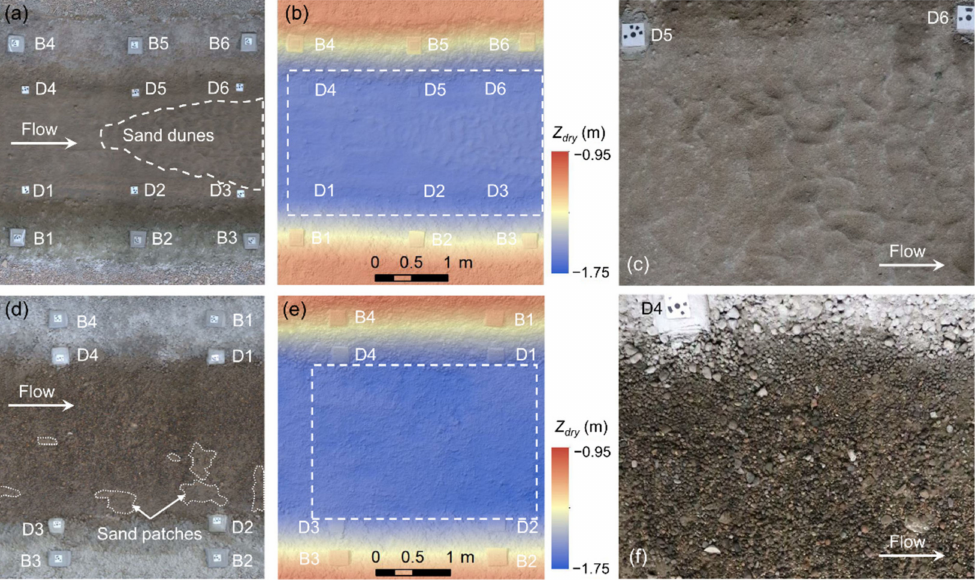
Figure 1. ( a ) Planform scheme of the flume system in which the monitored reach 1 and 2 (MR1 and MR2) are marked by black dashed squares (unit: meter); ( b ) photograph of the flume with MR1 and MR2 marked by green dashed squares; ( c ) photograph of the measuring frame and mobile cart.